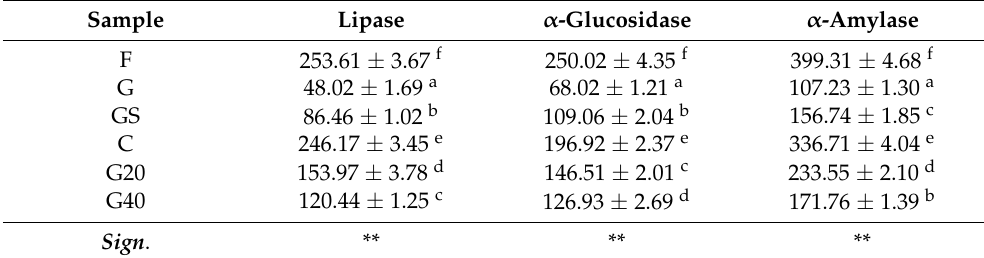
Table 7. Lipase, α -glucosidase, and α -amylase inhibitory activities [IC 50 ( µ g/mL)] of fresh and processed goji fresh puree and enriched ciabatta